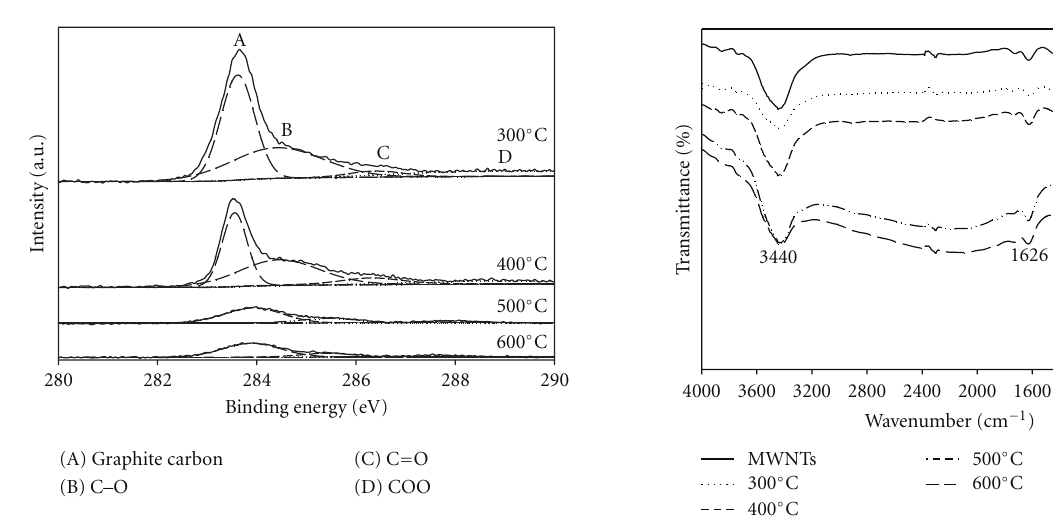
Figure 5: X-ray photoelectron spectra of MWNT-TiO 2 at four di ff erent calcination temperatures (300, 400, 500, and 600 ◦ C). Figure 6: Fourier transform infrared spectra of MWNT-TiO 2 at four di ff erent calcination temperatures (300, 400, 500, and 600 ◦